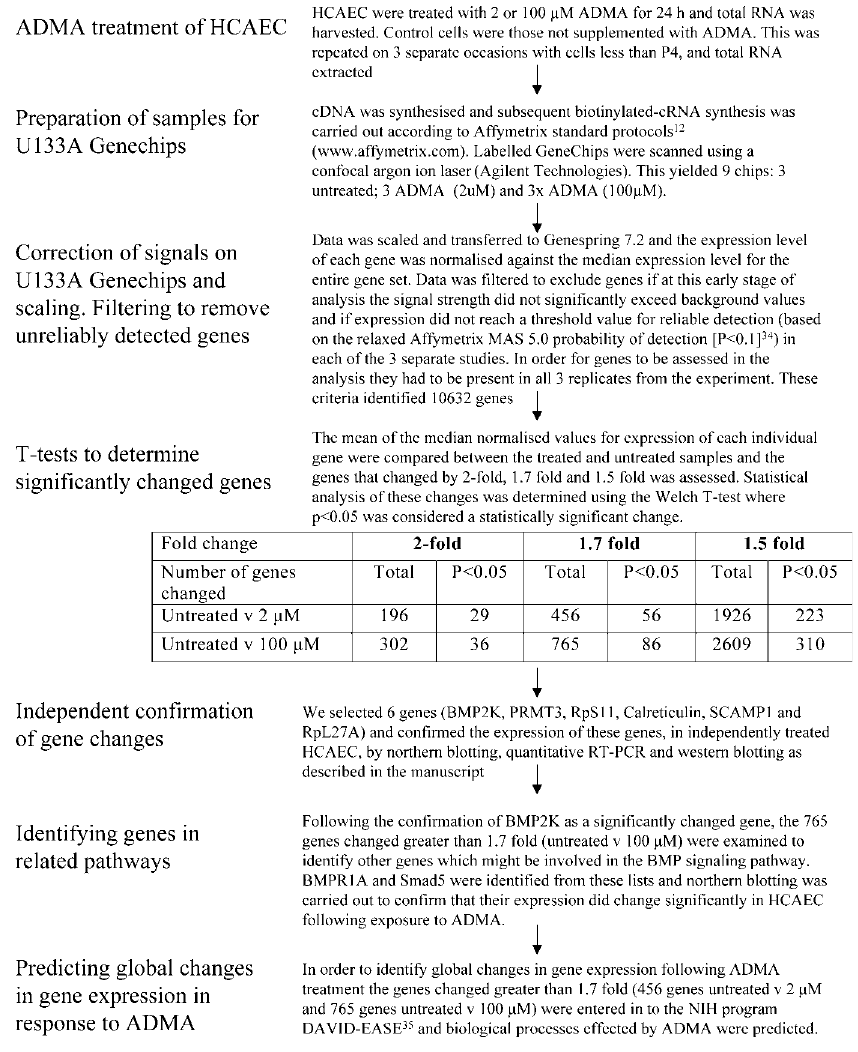
Figure 1. Flow Diagram Summarising the Methods Used in This Manuscript DOI: